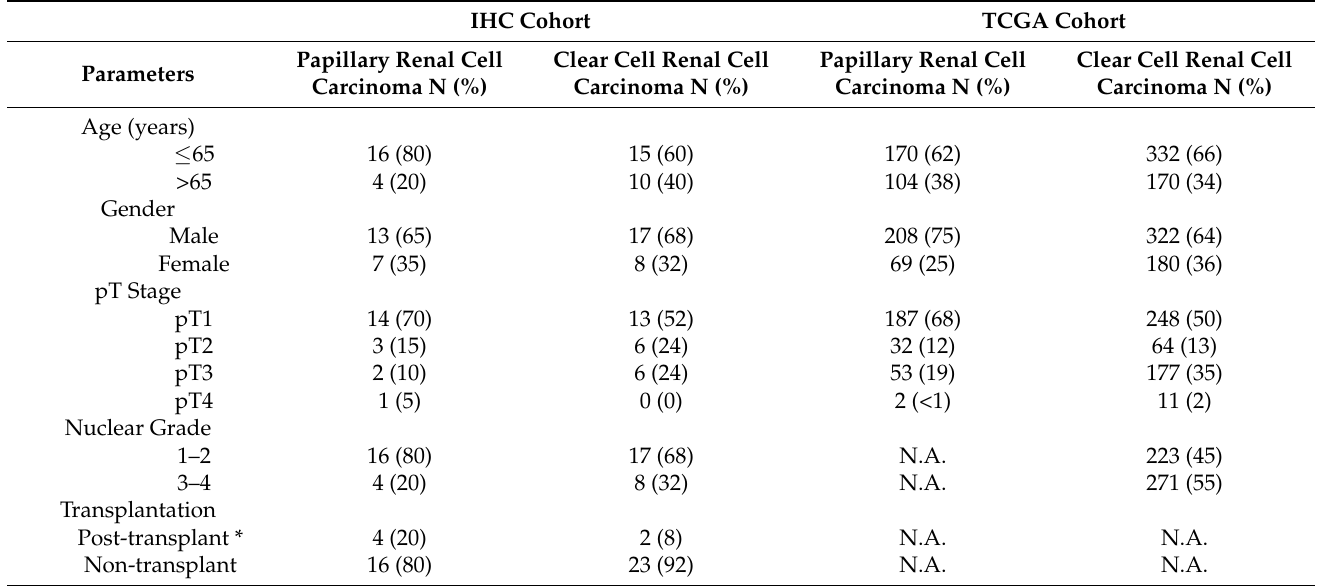
Table 1. Clinicopathological